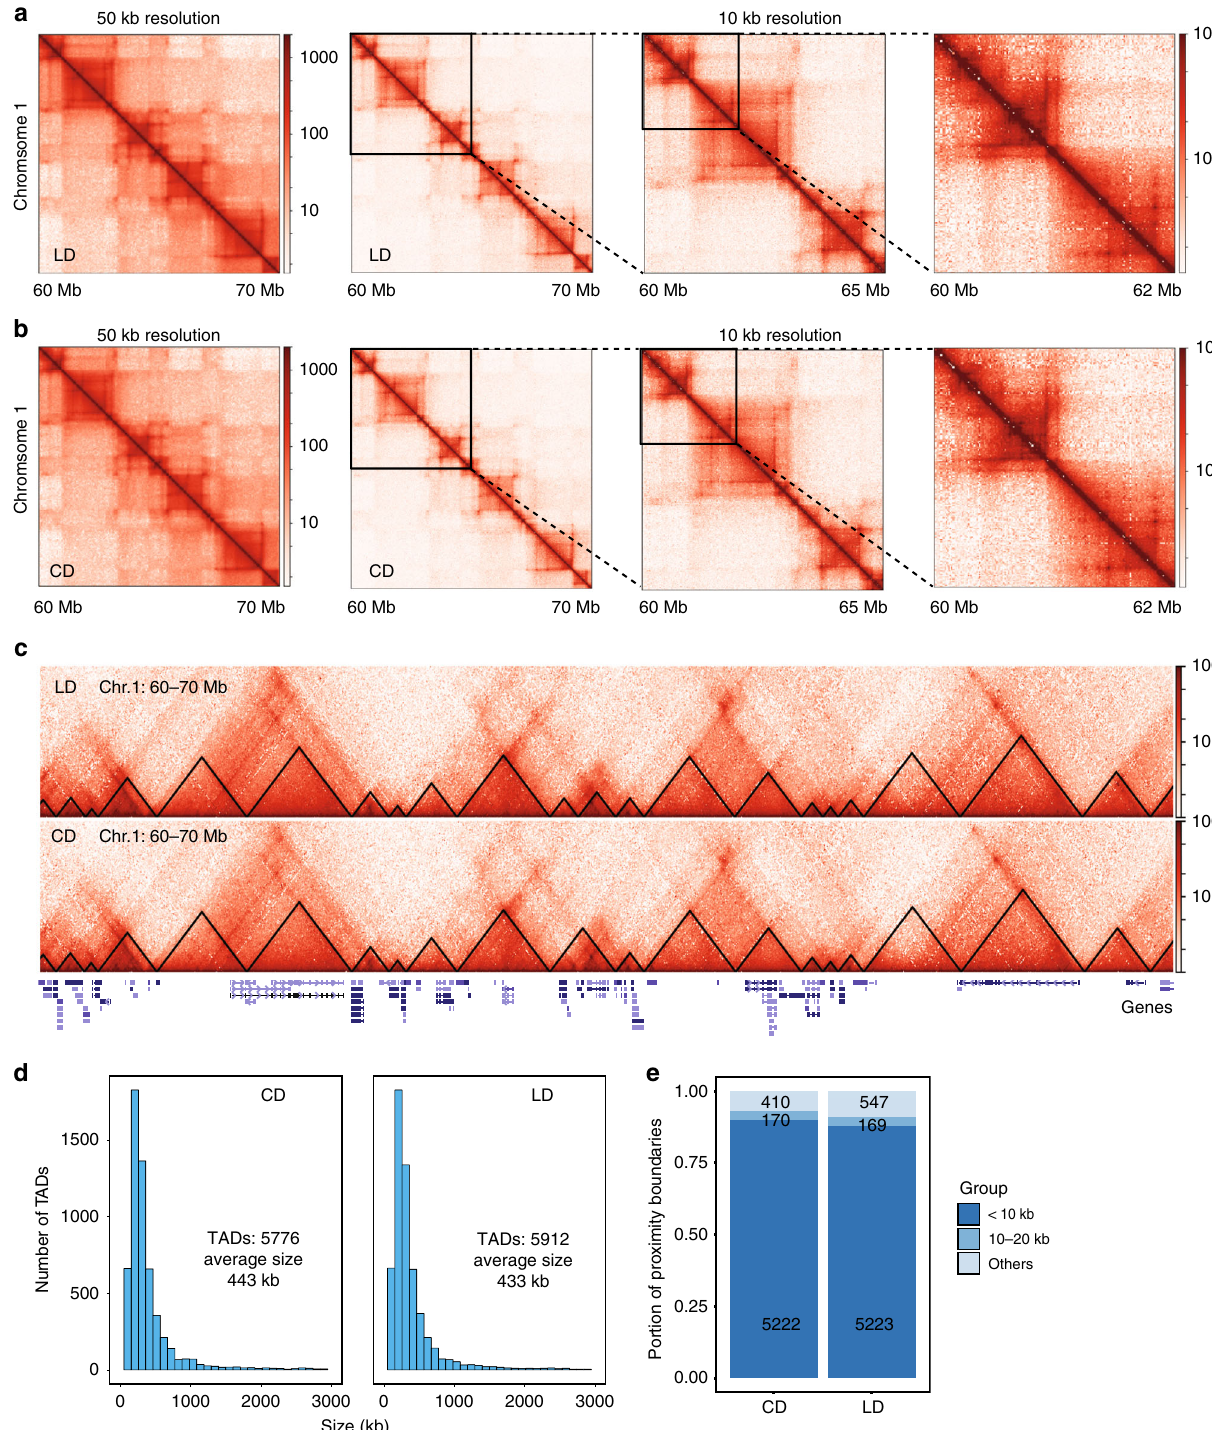
Fig. 3 High order chromatin organization in liver during chronic obesity. a , b Hi-C contact matrix depicting normalized contact frequencies in carbohydrate-rich diet (CD, Panel a ) or lipid-rich diet (LD, Panel b ) group at 50 and 10 kb bins ( n = 2 per group). Examples at Chr1: 60 – 70 Mb. c Examples of TADs (Black triangle represents the TAD) and genes in Chr1: 60 – 70 Mb in LD and CD group. d Histograms of distribution of sizes of the TADs in CD and LD group. e Percentage of proximity TAD boundaries in CD and LD